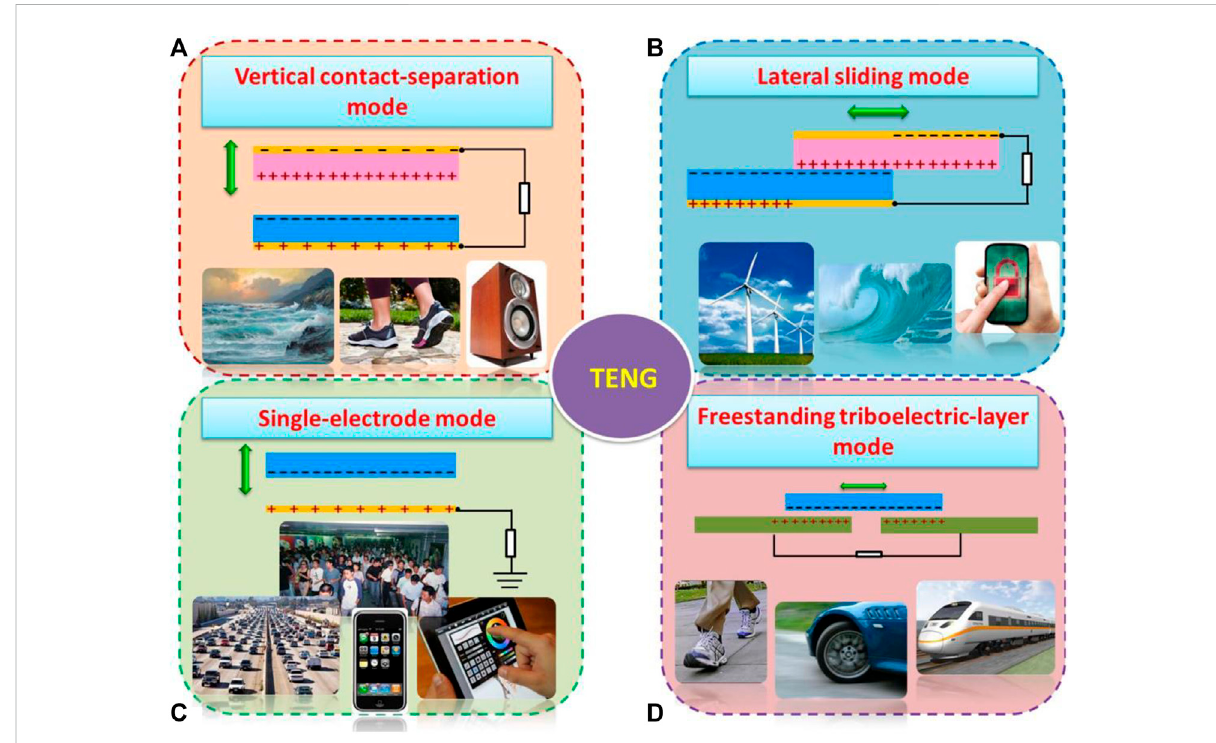
FIGURE 9 The four modes of operation of the TENG (Wang, 2015). (A) Vertical contact-separation mode, (B) lateral sliding mode, (C) single-electrode mode, (D) freestanding triboelectric-layer